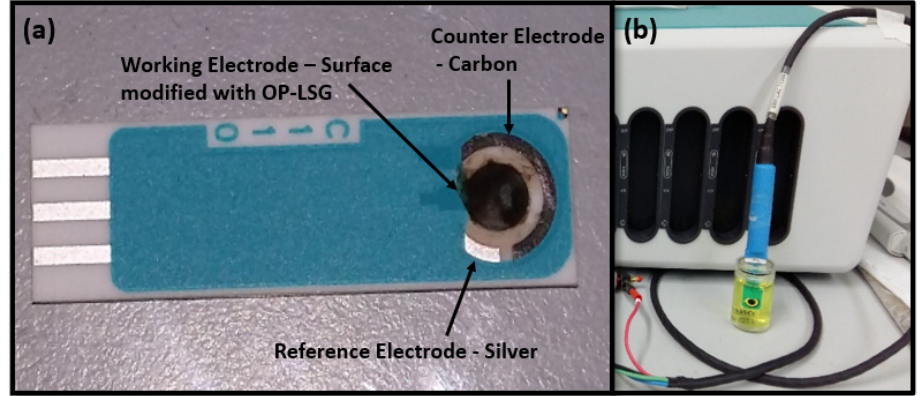
Fig. 1. (a), The SPE chip with surface modified OP-LSG working electrode, carbon counter electrode, and silver reference electrode. (b), The modified SPE chip in a ferrocyanide electrolyte solution for electrochemical performance testing of the OP-LSG